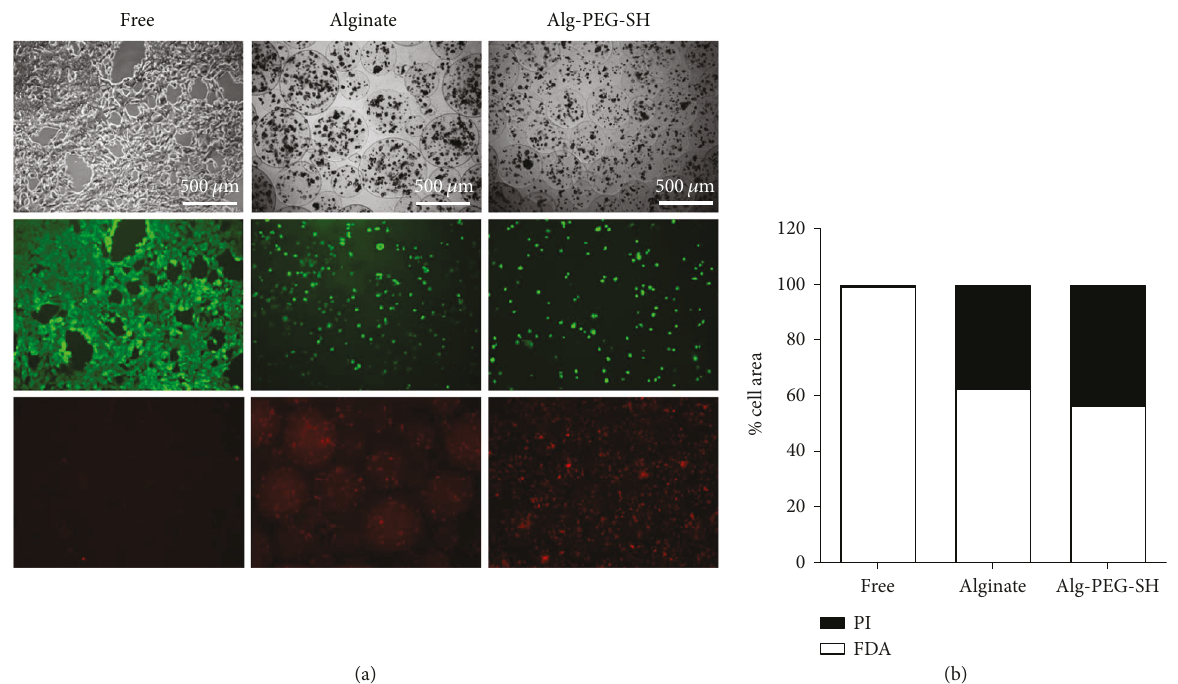
Figure 3: Viability of free and microencapsulated hepatocytes. (a) Representative images at day 3 for free, Alg-microencapsulated, and Alg- PEG-SH-microencapsulated hepatocytes. Upper panels present bright- fi eld images, middle panels present viable cells (FDA staining), and lower panels present nonviable cells (PI staining). (b) Quanti fi cation of viable cells (FDA) and nonviable cells (PI) at day 3. Values are expressed as % of the total cell area ( n = 6 ). Quanti fi cation has been performed using